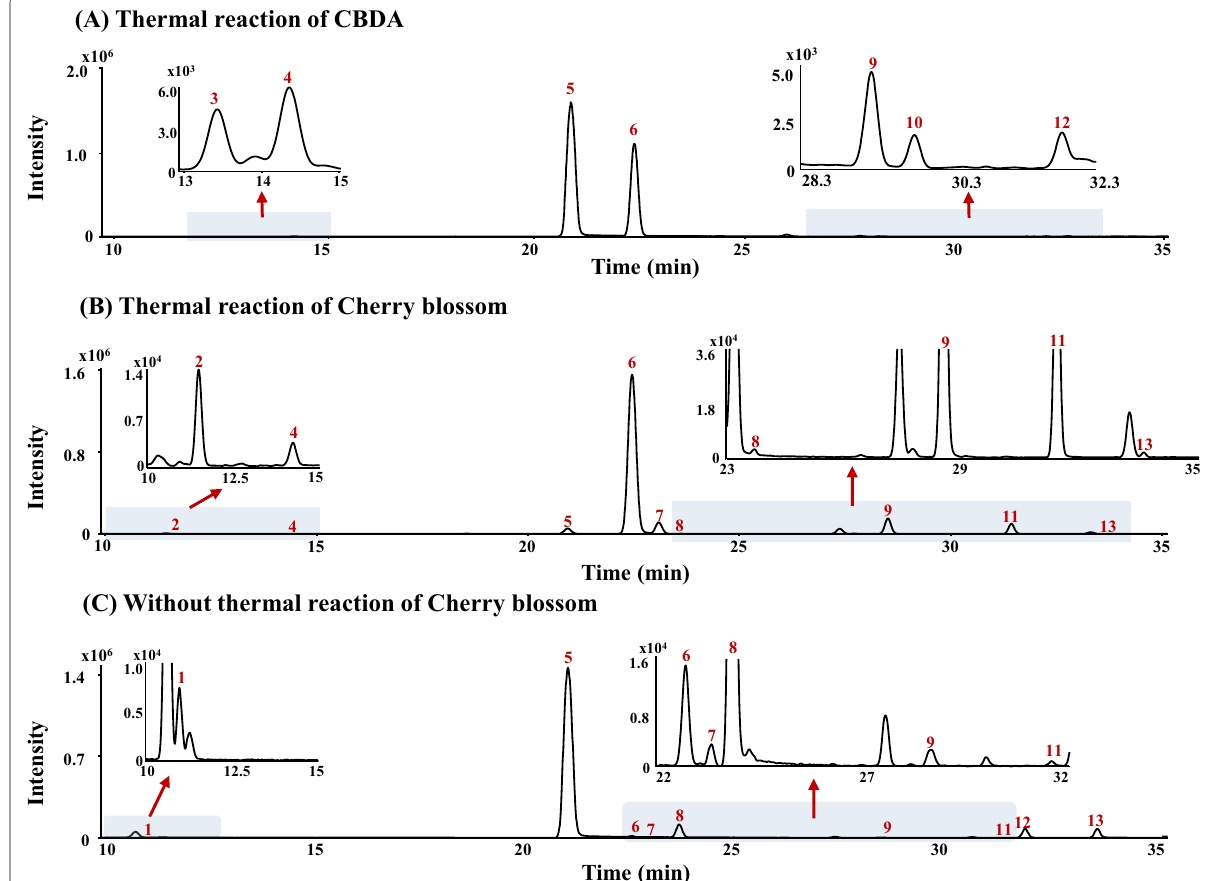
Fig. 3 TICs of A isolated CBDA, B extract of Cherry blossom after heat treatment at 130 °C for 30 min and C without heat treatment of Cherry blossom. Peak identities as follows: 1. CBDVA, 2. CBDV, 3. CBEA, 4. CBE, 5. CBDA, 6. CBD, 7. CBG, 8. CBGA, 9. ∆9-THC, 10. ∆8-THC, 11. CBC, 12. THCA,